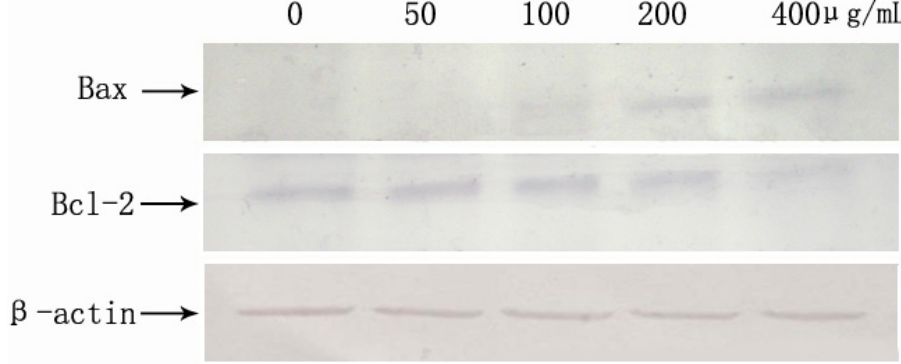
Figure 9. Effects of the SFE-CO by Western